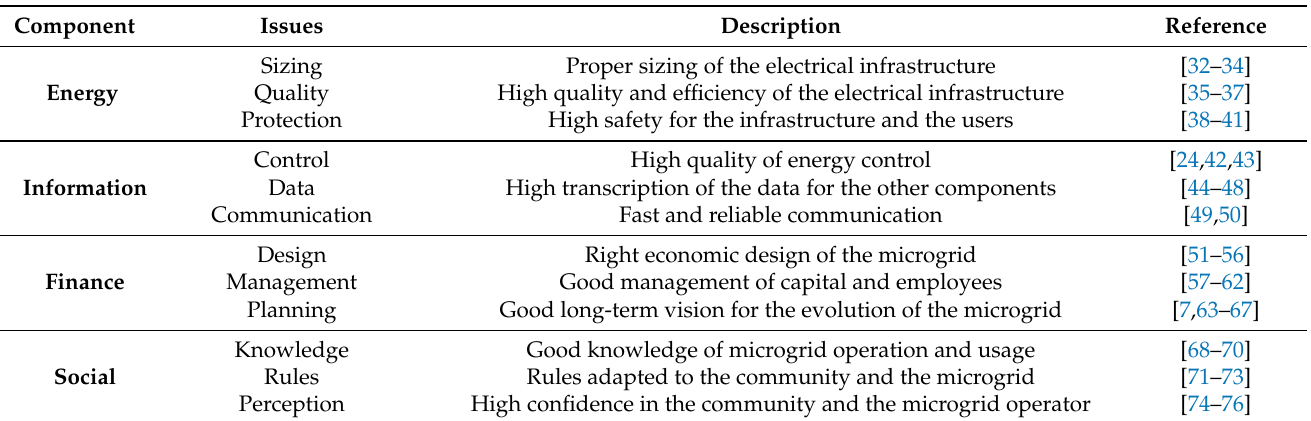
Table 1. List of the issues of microgrid